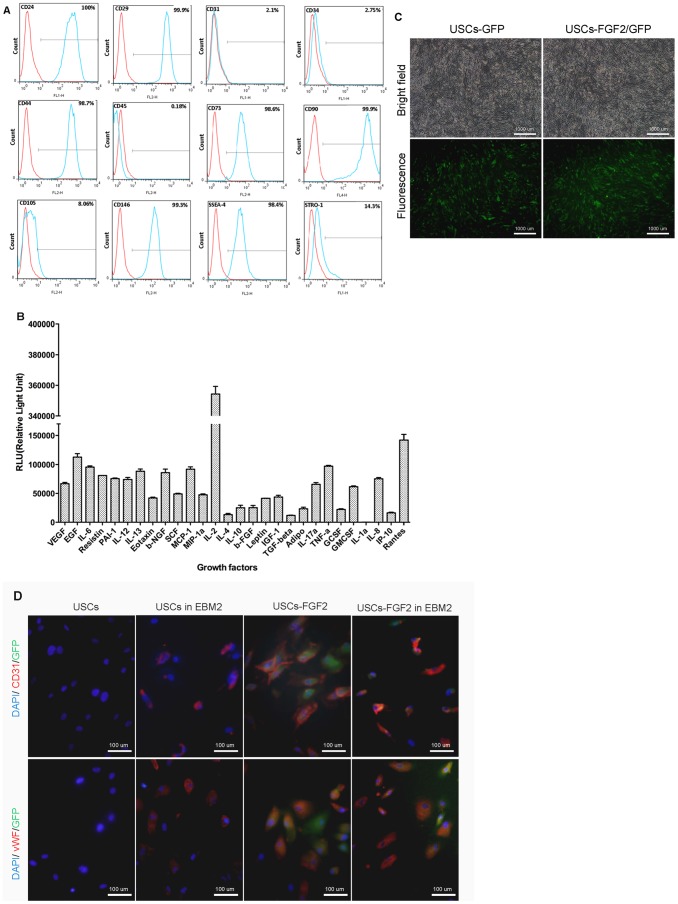
Characteristic of human urine-derived stem cells in vitro.(A) Flow cytometric analysis revealed that USCs (p3) display mesenchymal stem cell surface markers (CD24, CD29, CD44, CD73, CD90, CD105, CD146, SSEA4 and STRO-1), but were negative for hematopoietic stem cell markers (CD31, CD34, CD45). (B) USCs secreted series proangiogenic growth factors. (C) USCs displayed green fluorescence after over-expressing GFP or FGF2/GFP. (D) Triple immunofluorescence staining (green-GFP, red-CD31/vWF, blue-DAPI for nuclear staining) for USCs or USCs-FGF2 cultured in normal USC medium or endothelial induction medium (EBM2).